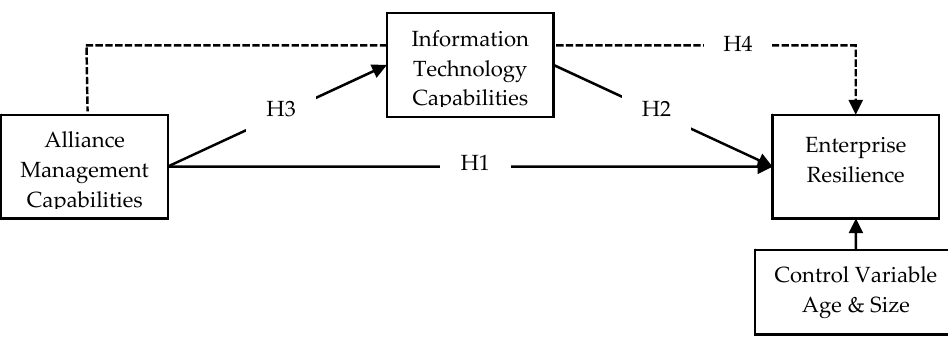
Figure 1. Research Figure 1. Research framework.